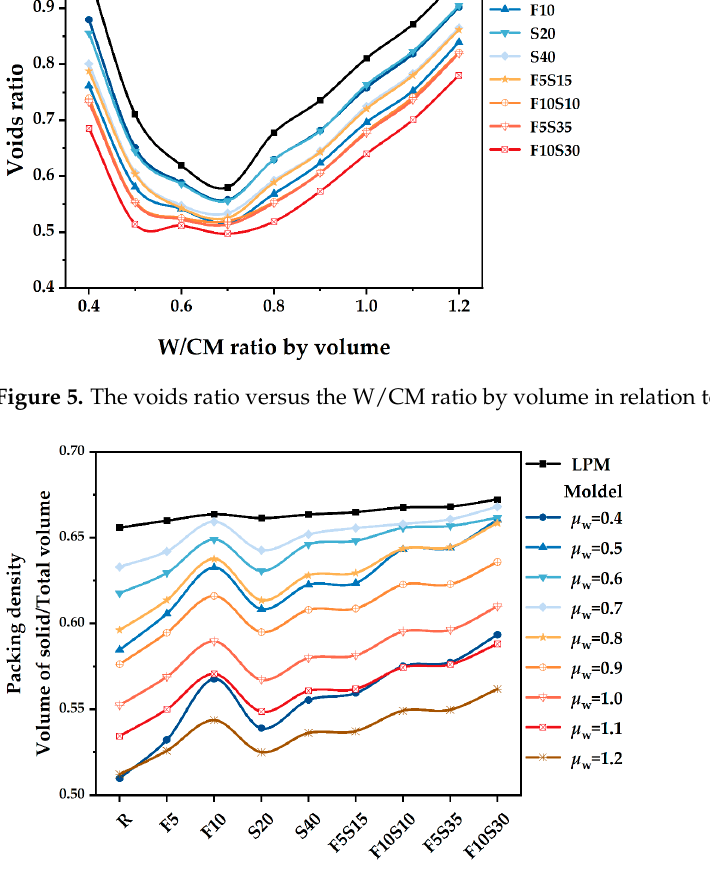
Figure 6. The packing density of binders paste containing OPC, slag, and SF.